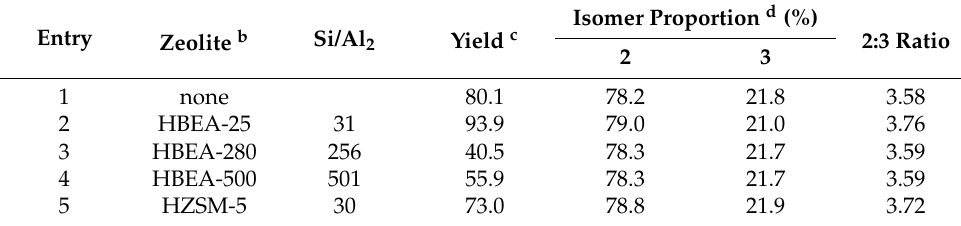
Table 2. The effect of zeolite type on the nitration of naphthalene with HNO 3 and acetic anhydride a .